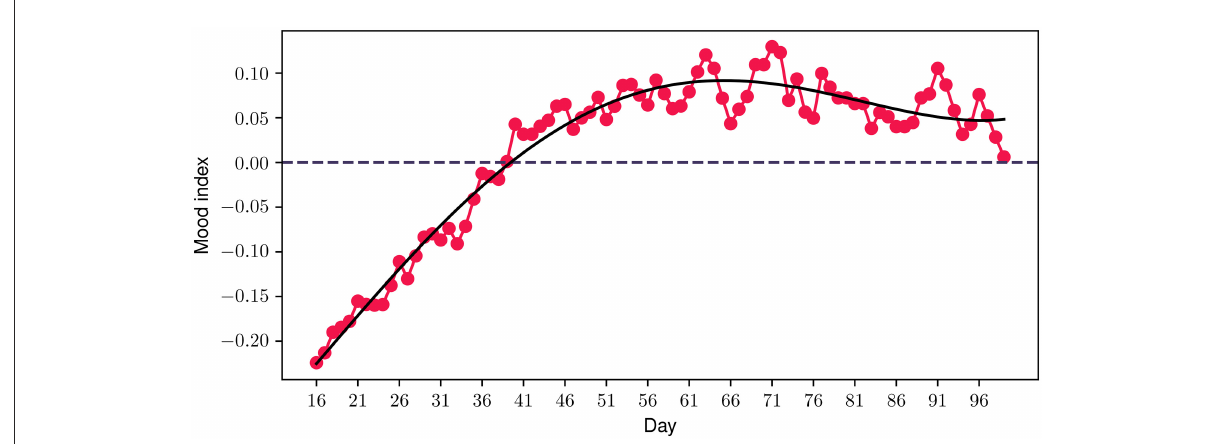
FIGURE9 Participant mood index progression during the program. The solid black line represents a polynomial fit.